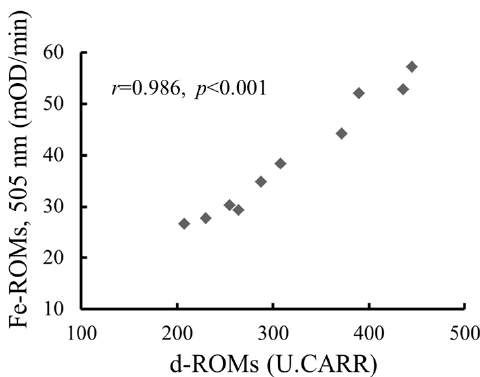
Figure 2. The correlation of Fe-ROMs values with diacron reactive oxygen metabolites (d-ROMs) values. The oxidative stress was evaluated by measuring plasma samples from 10 male patients. The rates of increase in absorbance at 505 nm were determined in the presence (Fe-ROMs test) and absence (d-ROMs test) of Fe 2+ , as described in the Section 4. The correlation between the values obtained from the d-ROMs and Fe-ROMs tests was expressed by Pearson’s correlation coefficient ( r = 0.986, p < 0.001). U.CARR, Carratelli units.